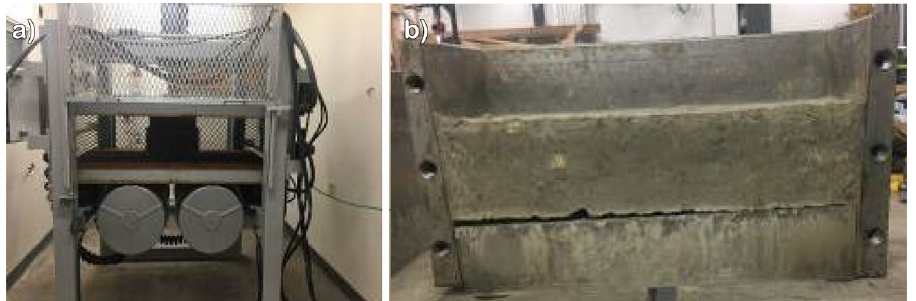
Common compounds noted by construction cement manufactur-